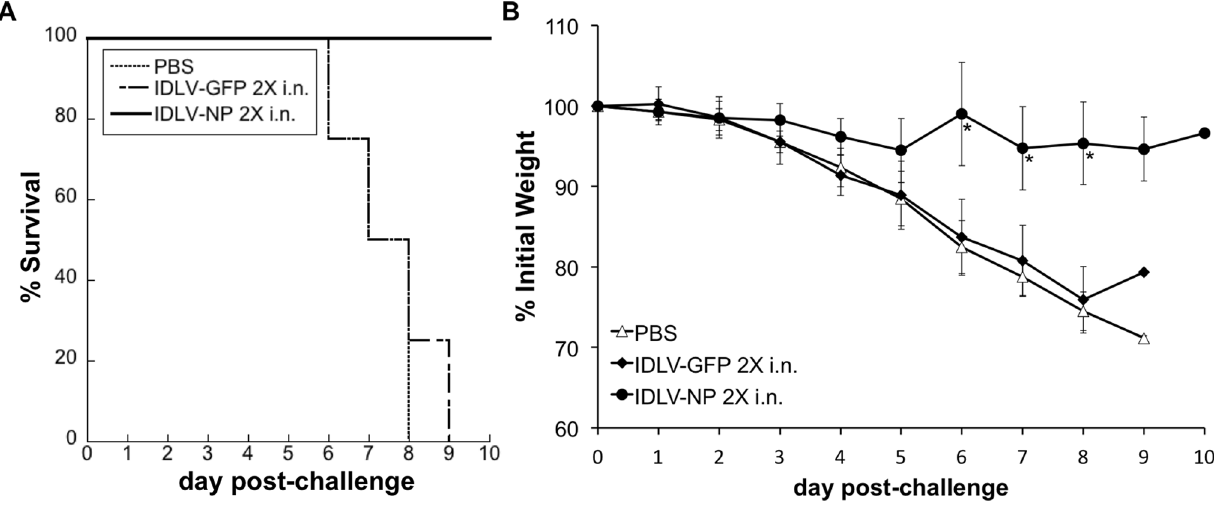
Figure 7. Immunization with IDLV protects mice from challenge with influenza virus in an antigen-specific manner. Mice were inoculated 2 times i.n., 4 weeks apart, with IDLV-NP (n=5) or IDLV-GFP (n=4). Mice that received PBS 2 times i.n. (n=4) served as a negative control for protection. Four weeks after the final administration, mice were challenged with a lethal dose (5 LD50) of the mouse-adapted A/Philippines/ 1982:PR8 influenza virus. Survival ( A ) and weight loss ( B ) were monitored for 10 days following challenge. Weight loss is presented as the average percentage of initial weight at the time of challenge. *indicates days when IDLV-NP 2X i.n. lost significantly less weight than any of the other immunization regimens (p , 0.005, calculated using pairwise group comparisons, at each time point, based on the ANOVA test). Overall p-value for group comparisons was based on the Kruskal-Wallis test: p=0.029 for day 6, p=0.021 for day 7, p=0.026 for day 8.